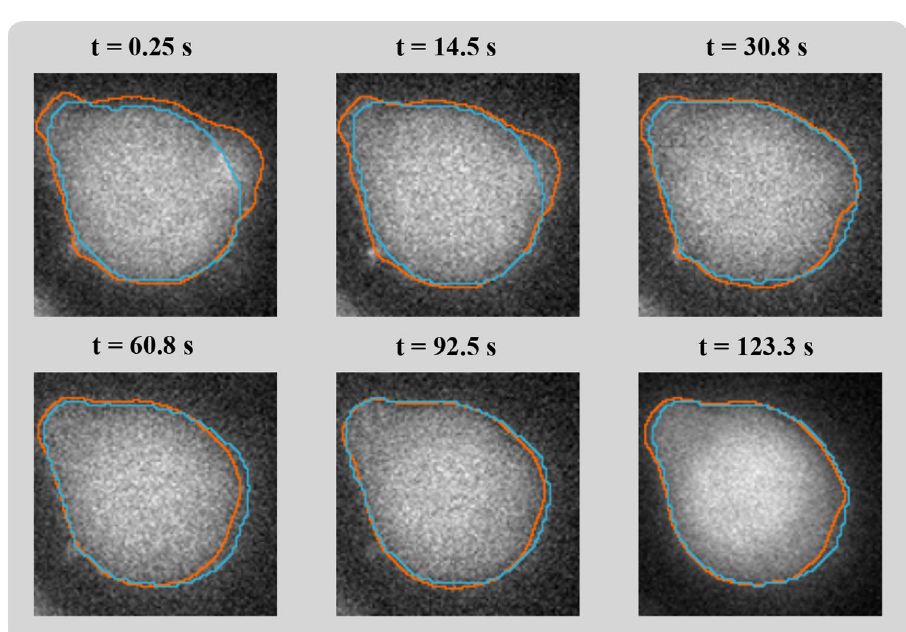
Figure 5. Illustration of task 1 results: Jurkat T-cell segmentation for six frames of a Fluo-4 Ca 2 + imaging sequence. Blue: segmented mask border for the standard U-Net model. Orange: cell borders obtained by the reservoir computing model [Graphics created in MATLAB and the Image Processing Toolbox Release 2019b, The MathWorks, Inc. (http:// mathw orks. com/ produ cts/ image.